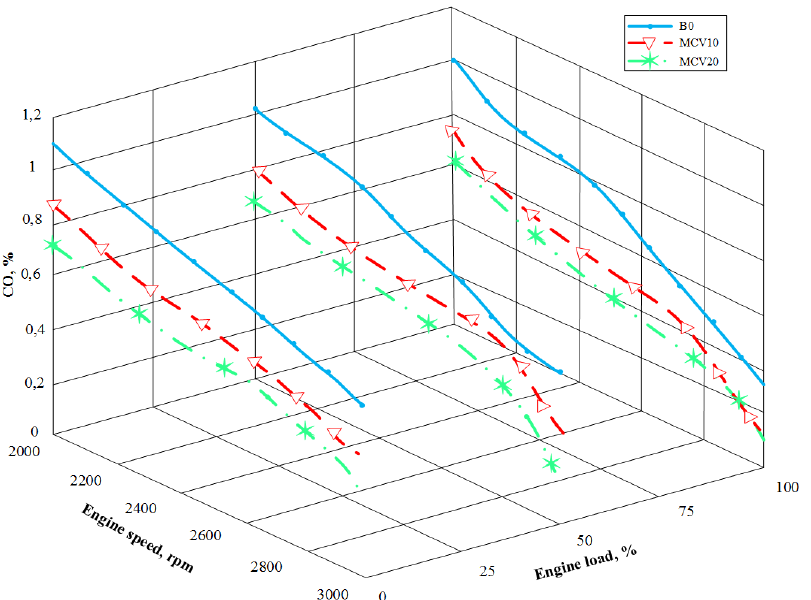
Fig. 6. CO emissions of MCV biodiesel blends at different